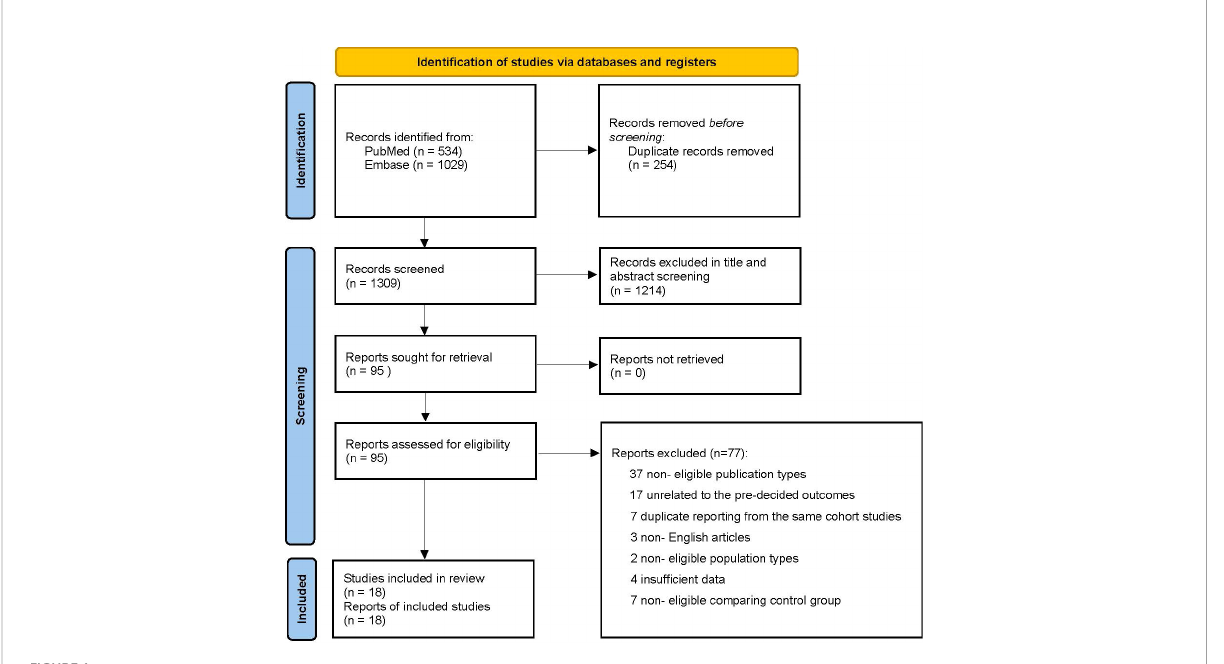
FIGURE 1 PRISMA fl ow diagram showing study